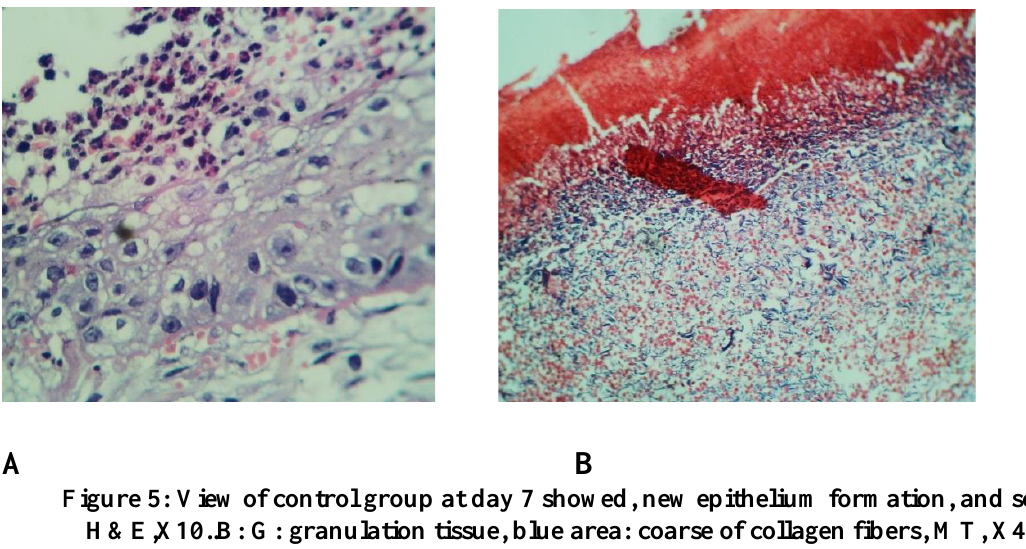
Figure 5: View of control group at day 7 showed, new epithelium formation, and scab, H&E,X10..B: G: granulation tissue, blue area: coarse of collagen fibers, MT, X40. Seven days duration (Experimental group): Fig. 6